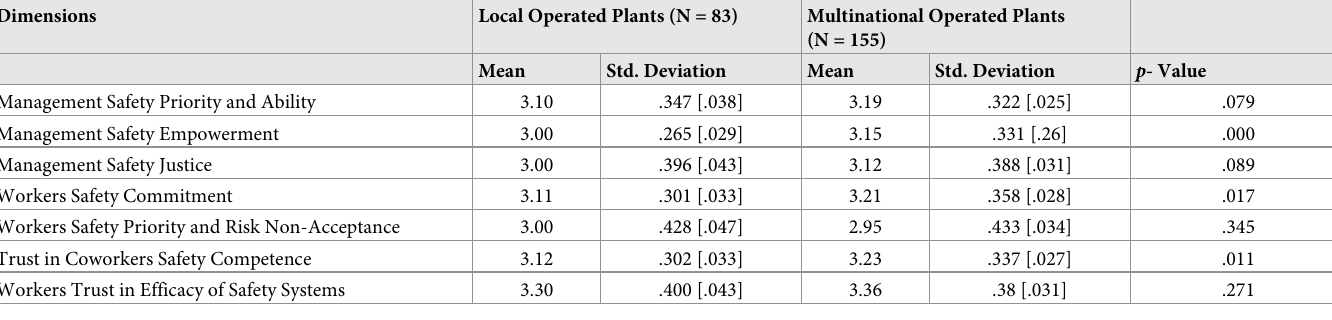
Table 3. Overall safety climate comparison between local and multinational employers.